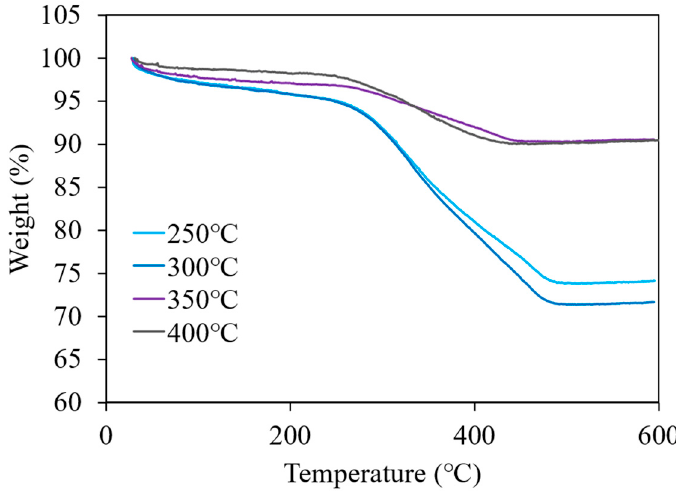
Figure 4. FTIR spectra obtained for PHA-modified ZrO 2 nanoparticles synthesized at various temperatures: ( a ) 250 °C, ( b ) 300 °C, ( c ) 350 °C, and ( d ) 400 °C.